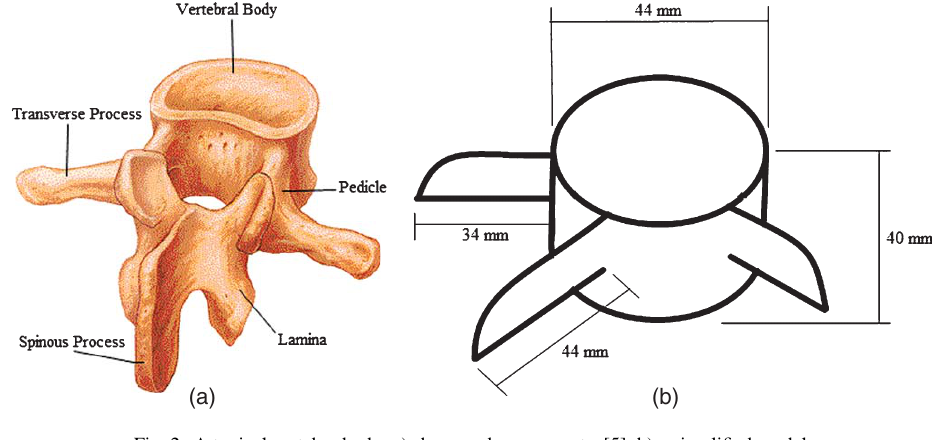
Fig. 2. A typical vertebra body: a) shape and components, [5]; b) a simplified model.